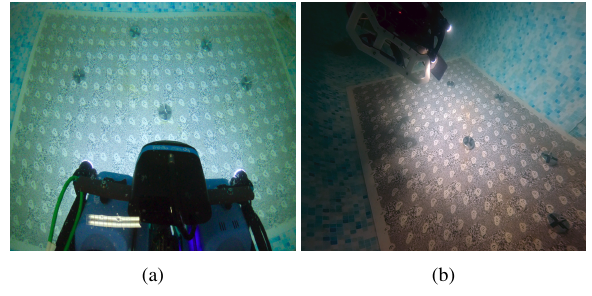
Figure 7. Opto-acousitc targets deployment